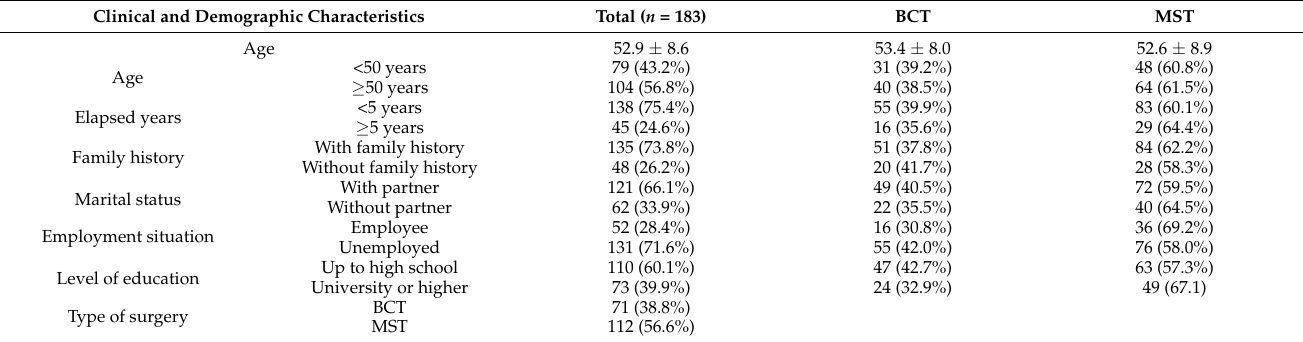
Table 1. Clinical and demographic characteristics of the study